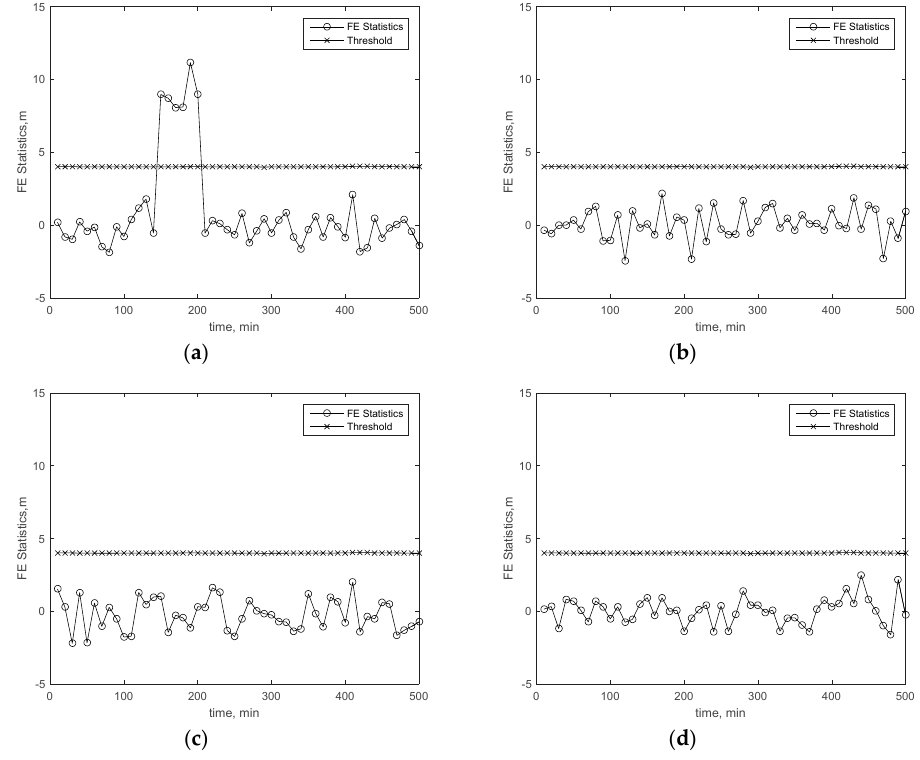
Figure 5. FE test results over all time in the first case. ( a ) FE test of the first satellite, ( b ) FE test of the second satellite, ( c ) FE test of the third satellite, and ( d ) FE test of the fourth satellite.